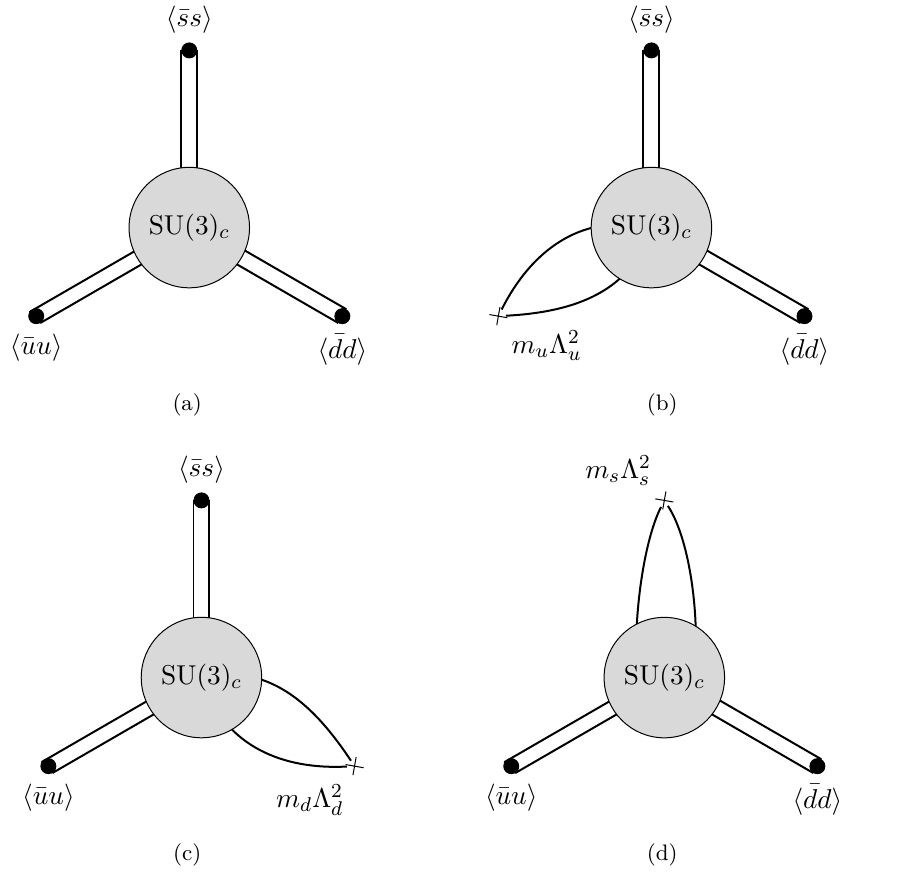
Figure 1 . The leading instanton diagrams from the determinantal interaction in eq. (3.3), organized by their chirality-changing source terms. Diagram (a) uses only the quark condensate, denoted by • , while diagrams (b) − (d) each use one insertion of a light quark mass, symbolized by ×